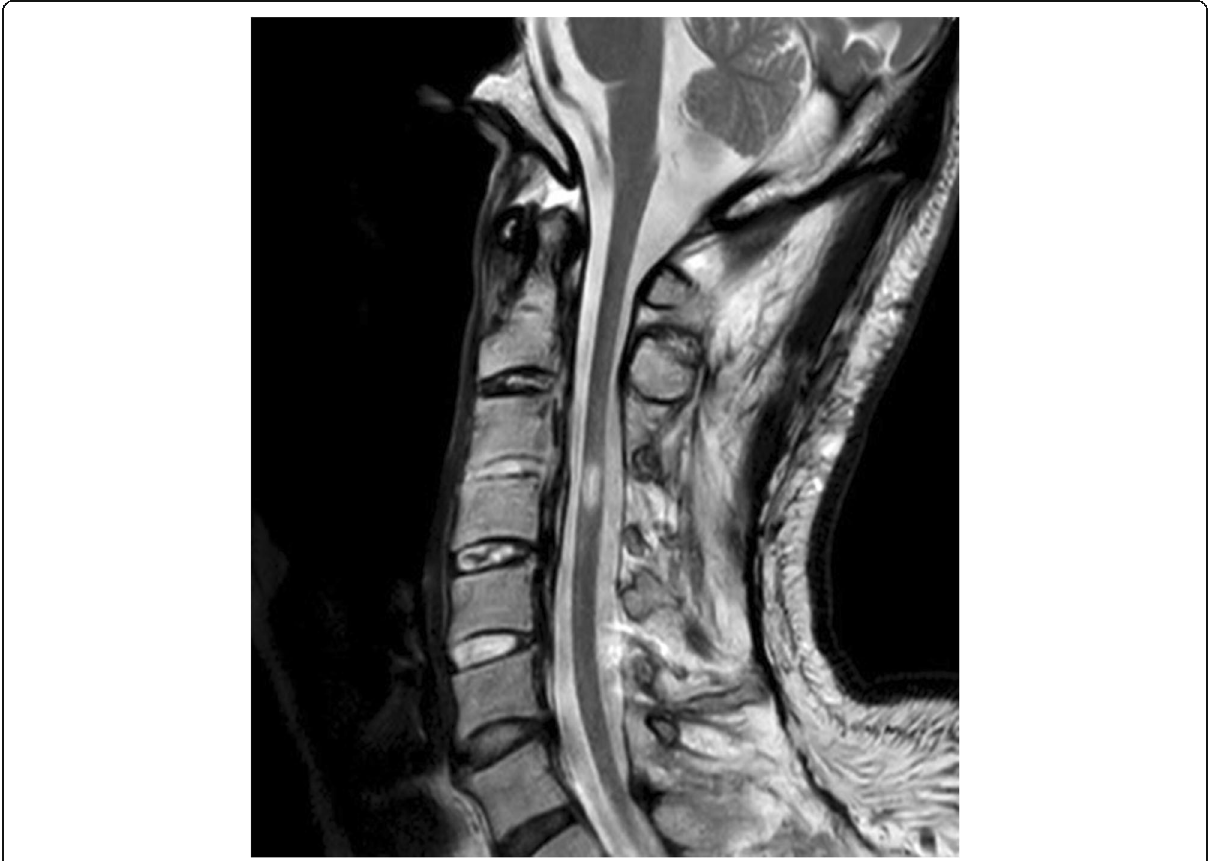
Fig. 1 A cervical spine sagittal T2-weighted magnetic resonance image showing a C3-C4 spinal cord